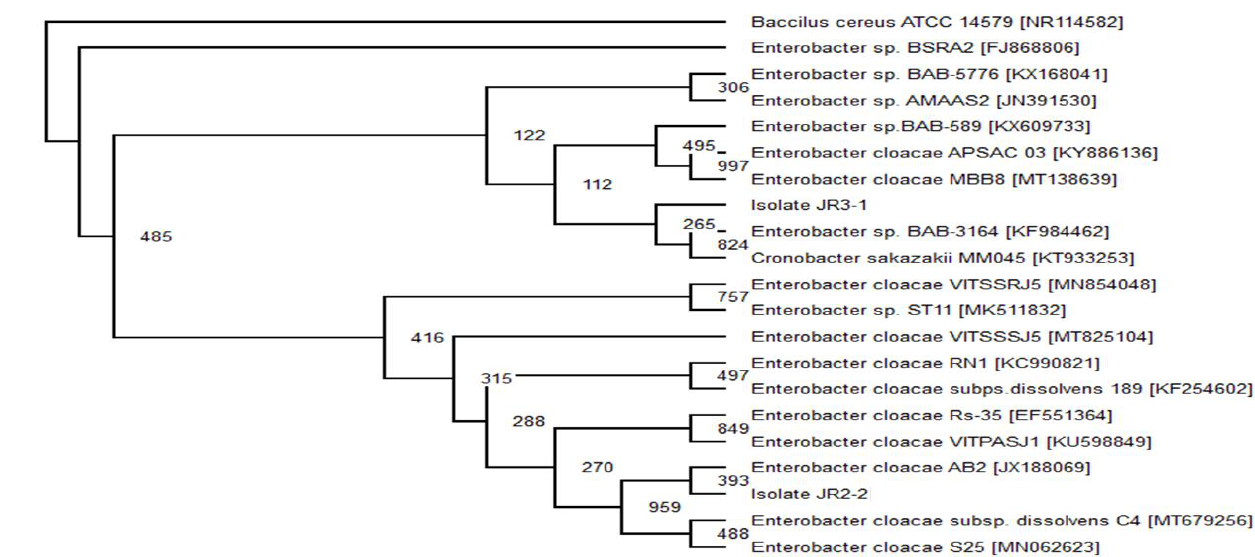
Figure 2. The cladogram was carried our based-on neighbour-joining technique illustrating the phylogenetic relationship between isolate JR2-2 and JR3-1 with other interconnected analogous bacterium based on 16S rRNA gene sequence examination.